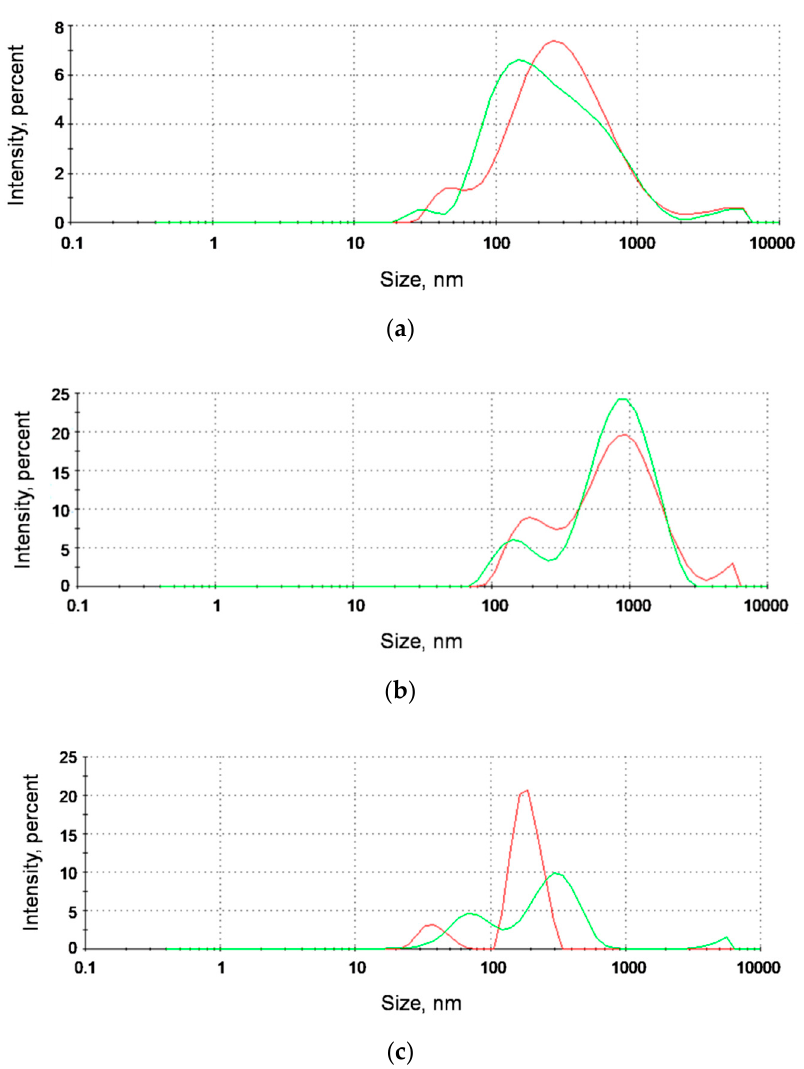
Figure 6. Mixed aggregation of AgNPs with ICR-191. ( a ) Hydrodynamic diameter of 64.63 µ g / mL naked AgNPs marked in red equals 371.9 nm. Overall average size of naked AgNPs–ICR-191 aggregates marked in green (concentrations: 64.63 µ g / mL and 78.87 µ M, respectively) equals 322.2 nm; ( b ) hydrodynamic diameter of 15.24 µ g / mL AgNP-TBA nanoparticles marked in red equals 199.3 and 996.9 nm. Overall average size of AgNP-TBA–ICR-191 aggregates marked in green (concentrations: 15.24 µ g / mL and 78.87 µ M, respectively) equals 158.6 and 954.8 nm; ( c ) hydrodynamic diameter of 3.12 µ g / mL AgNP-MUA nanoparticles marked in red equals 38.9 and 189.8 nm. Overall average size of AgNP-MUA–ICR-191 aggregates marked in green (concentrations: 3.12 µ g / mL and 77.03 µ M, respectively) equals to 73.8 and 308.0 nm. Measurements were performed in triplicate, and data are shown as average